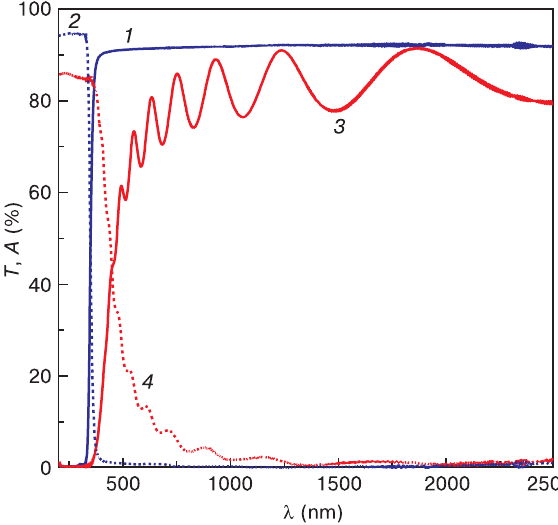
Figure 2. ( 1 and 3 ) Transmittance and ( 2 and 4 ) absorption spectra of ( 1 and 2 ) substrate and ( 3 and 4 ) typical